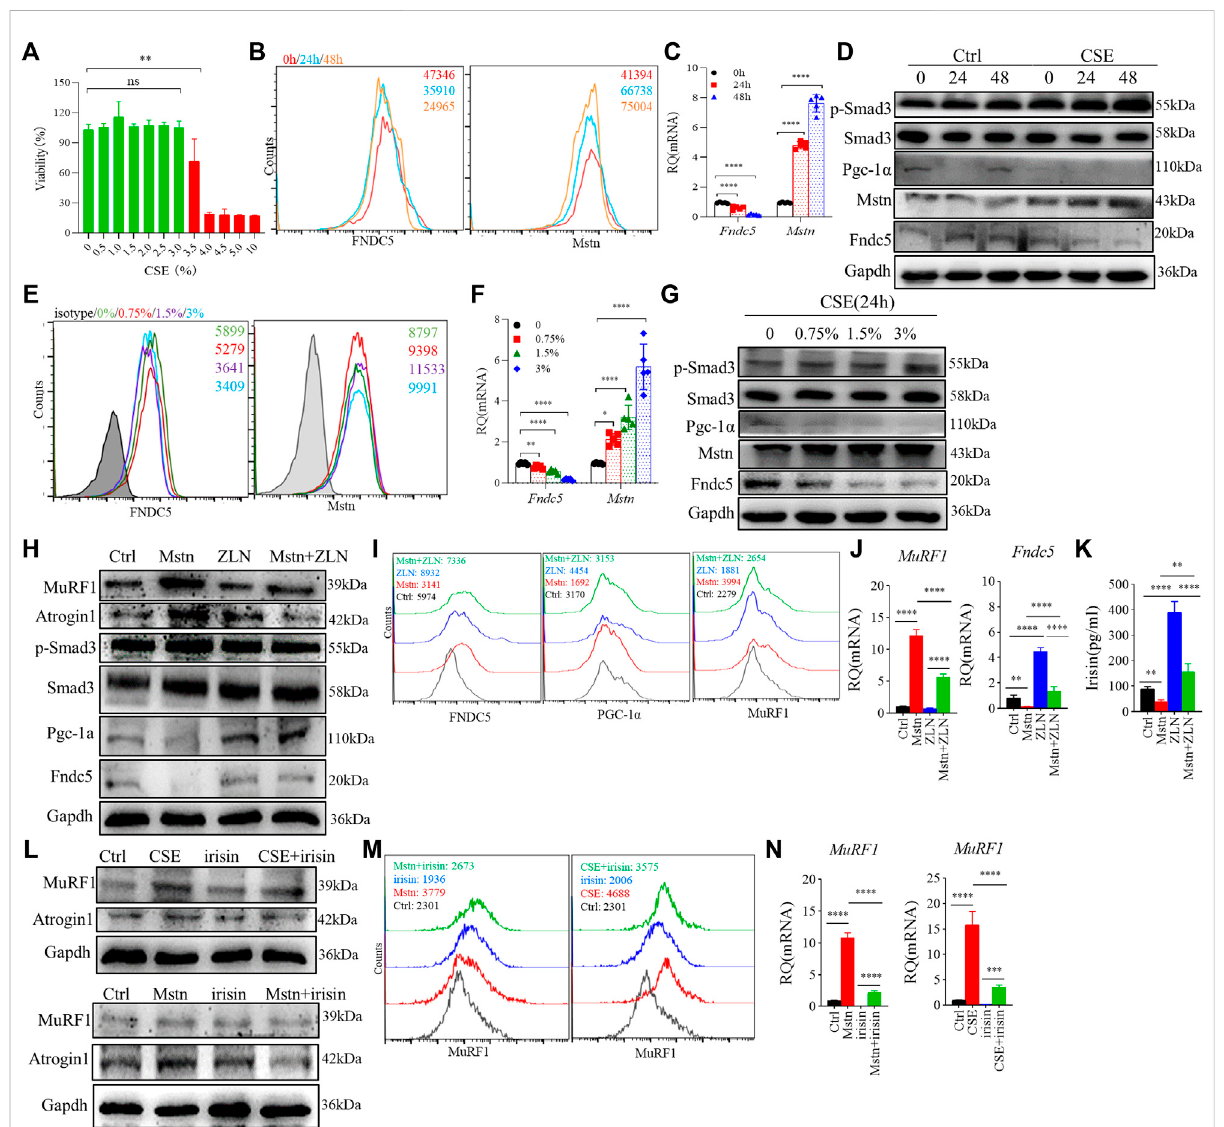
FIGURE 4 Cigarette smoke extract (CSE) altered myostatin (Mstn) and Fndc5 expression in C2C12 myotubes. (A) cell viability of C2C12 myotubes was tested in Dulbecco ’ s modi fi ed Eagle ’ s medium containing 10% fetal bovine serum and stimulated with different concentrations of CSE for 24 h. (B) histogram showing the mean fl uorescence intensity (MFI) of fi bronectin type III domain-containing protein 5 (Fndc5) and myostatin (Mstn) in 3% CSE-stimulated C2C12 myotubes at indicated time points. (C) expression of Fndc5 and Mstn in 3% CSE-stimulated C2C12 myotubes at indicated time points were detected using real-time quantitative PCR (RT-qPCR). (D) WB showing the expression of different proteins in 3% CSE- stimulated C2C12 myotubes. (E) histogram showing the MFI of Fndc5 and Mstn in CSE-stimulated C2C12 myotubes at different concentrations of CSE. (F) expression of Fndc5 and Mstn in CSE-stimulated C2C12 myotubes at different concentrations of CSE were detected using real-time quantitative PCR. (G) WB showing the expression of different proteins in CSE-stimulated C2C12 myotubes at different concentrations of CSE for 24 h. (H) WB showing the expression of different proteins in Mstn and/or ZLN005 (ZLN, 10 μ M)-stimulated C2C12 myotubes for 24 h, which also be detected using FACS (I) and RT-qPCR (J) . (K) supernatant of cell culture was detected using ELISA. (L) WB showing the expression of